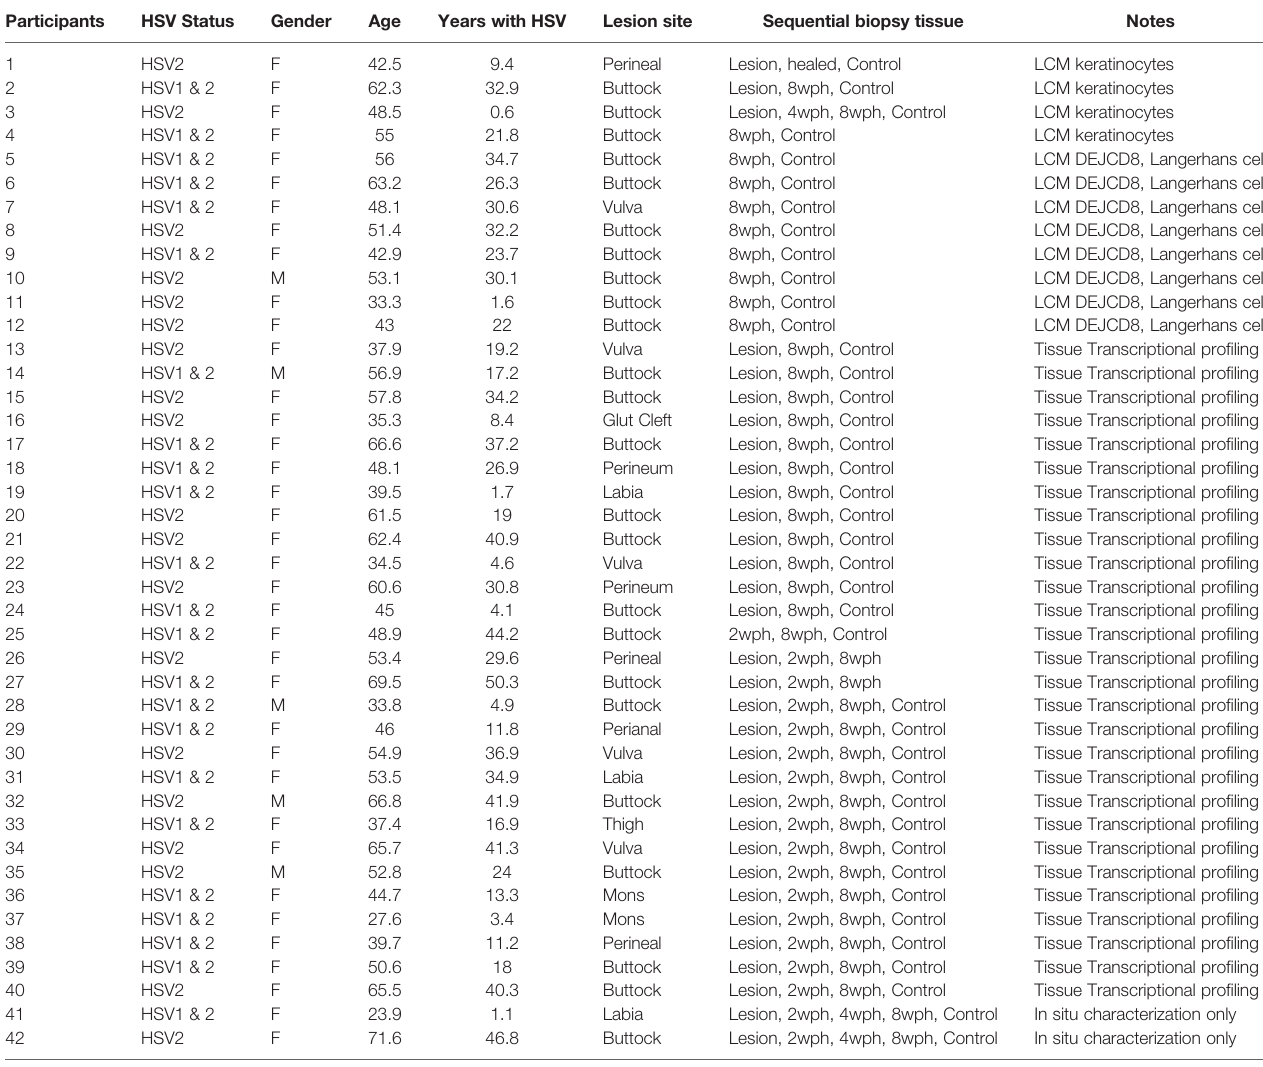
TABLE 1 | Demographic information of study participants and the types of biopsy tissue studied.